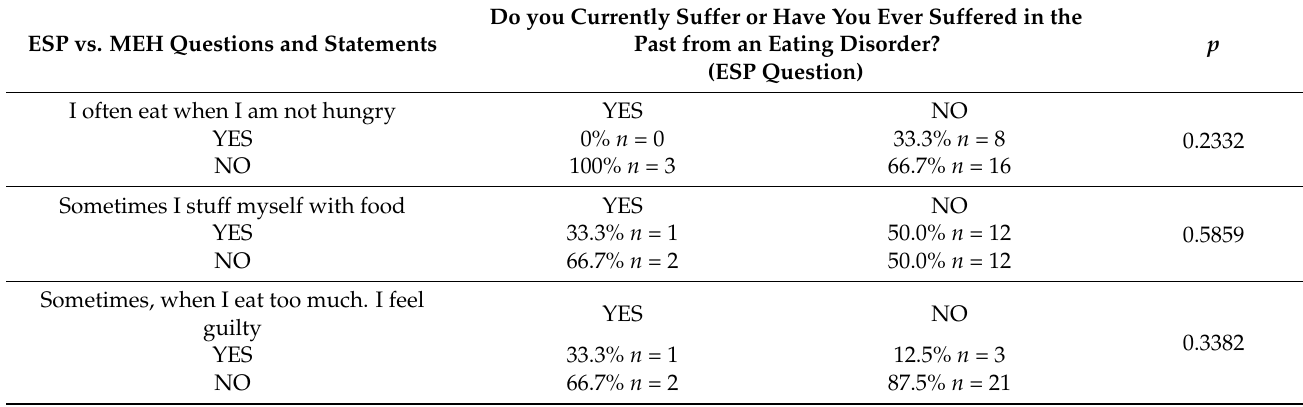
Table 13. The distribution of responses to selected statements from the “My Eating Habits” questionnaire in accordance with behaviors typical for people with binge-eating disorder in males.